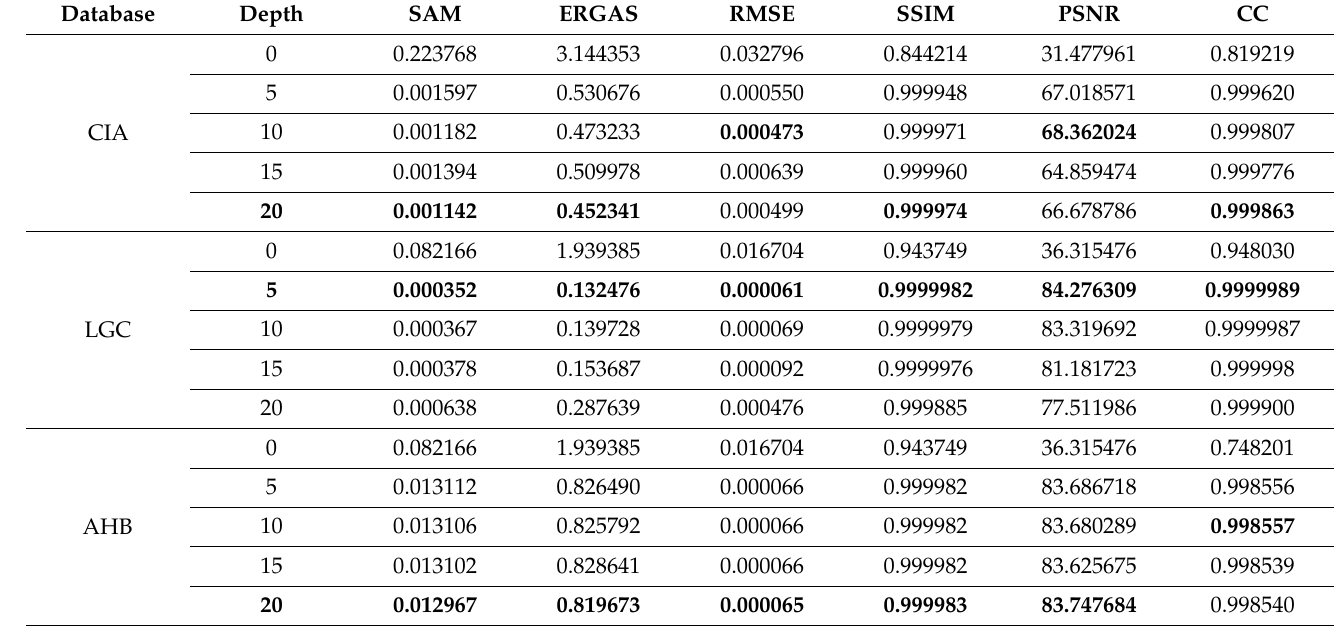
Table 4. Average evaluation values of ITEs of various depths on the three